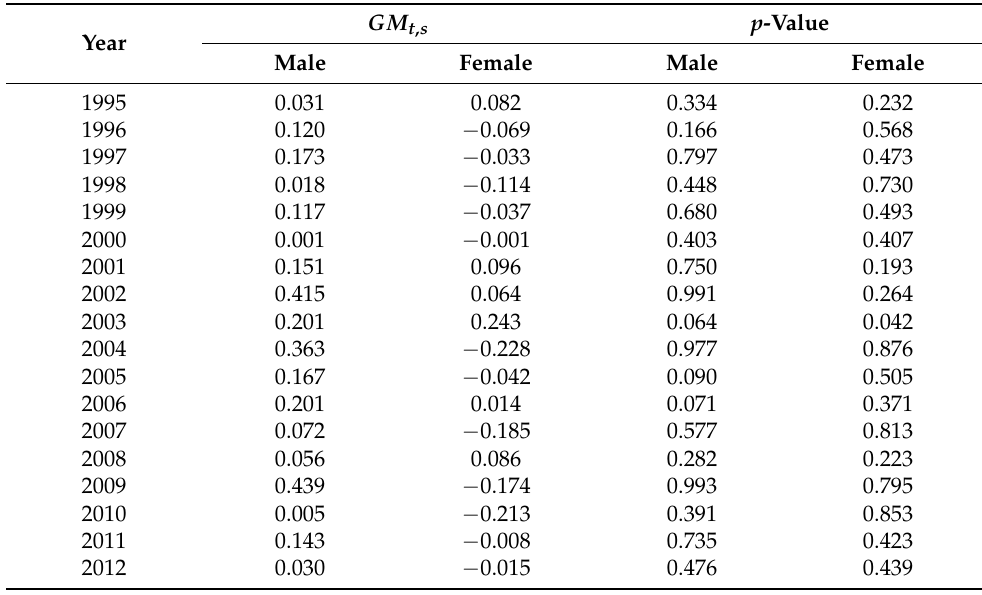
Table 6. Values of the Global Moran’s I and p -values by sex.